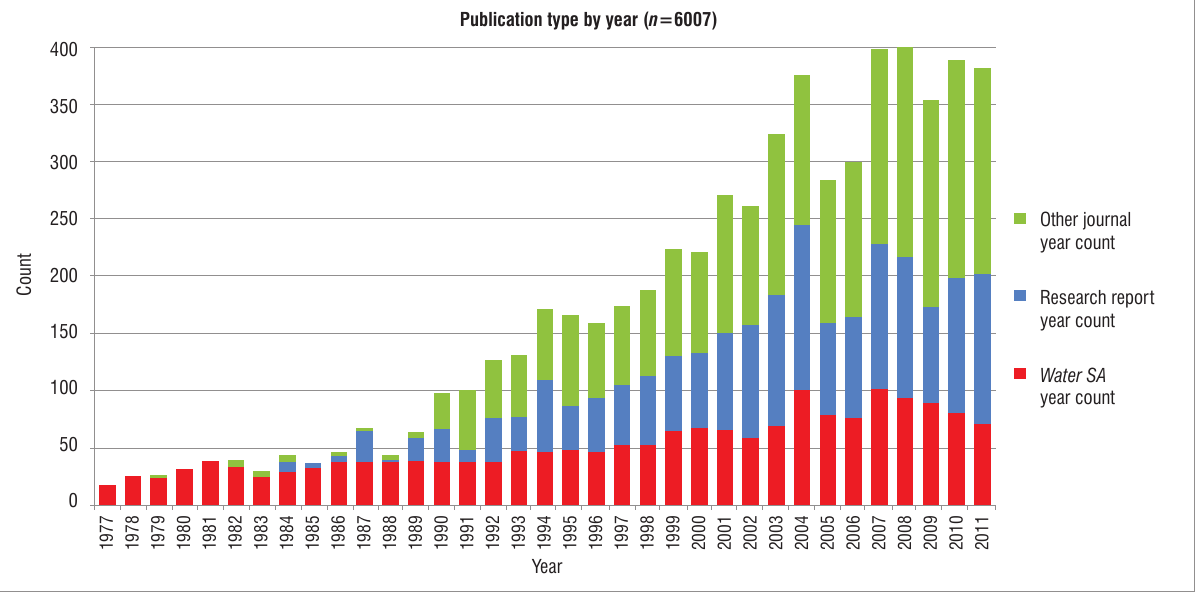
Figure 1: Publication type by year for all data points and all data